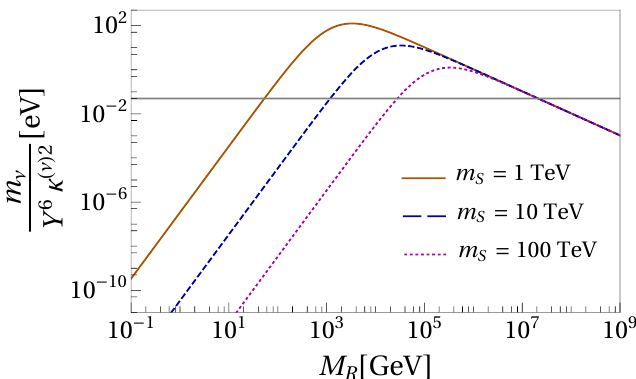
Figure 6 . Neutrino mass scale for di(cid:11)erent choices of the scalar masses. Here, we made simplifying assumptions M ((cid:9)) = M ((cid:9)) = M R for the exotic fermion masses and m (cid:8) 3 (cid:27)(cid:26) 2 (cid:13)(cid:14) scalars. The grey horizontal line denotes the atmospheric mass scale, i.e: m (cid:23)